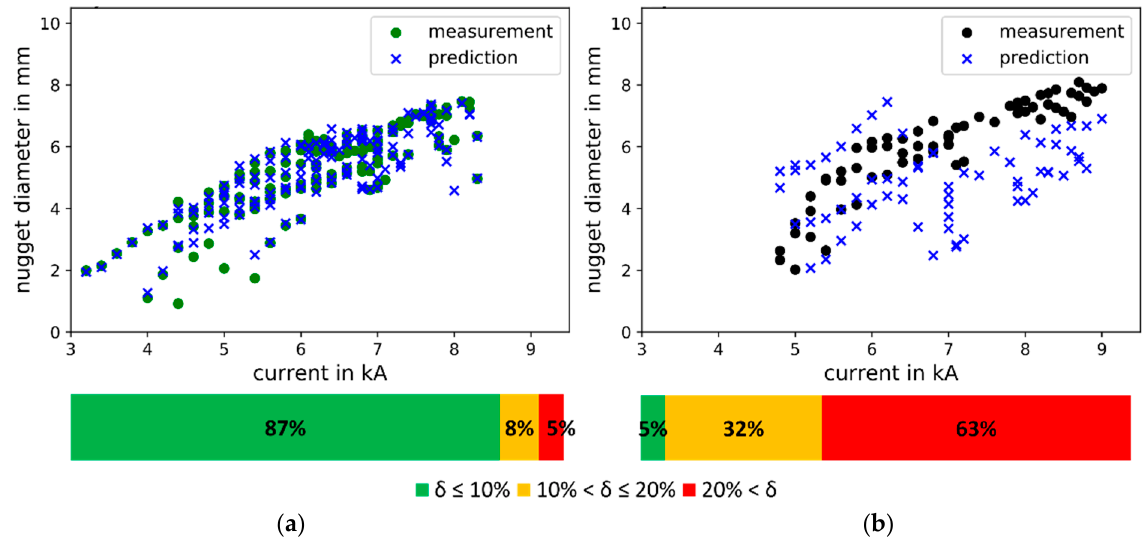
Figure 6. Predictive performance of the second model. The training included manually extracted dynamic resistance features: ( a ) scatter plot of the measured and predicted nugget diameters from dataset 1; ( b ) scatter plot of the measured and predicted nugget diameters from dataset 2. The bar charts show the predictive accuracy based on the prescribed deviation. The third MLP model was implemented with dataset 1 and validated with dataset 2.